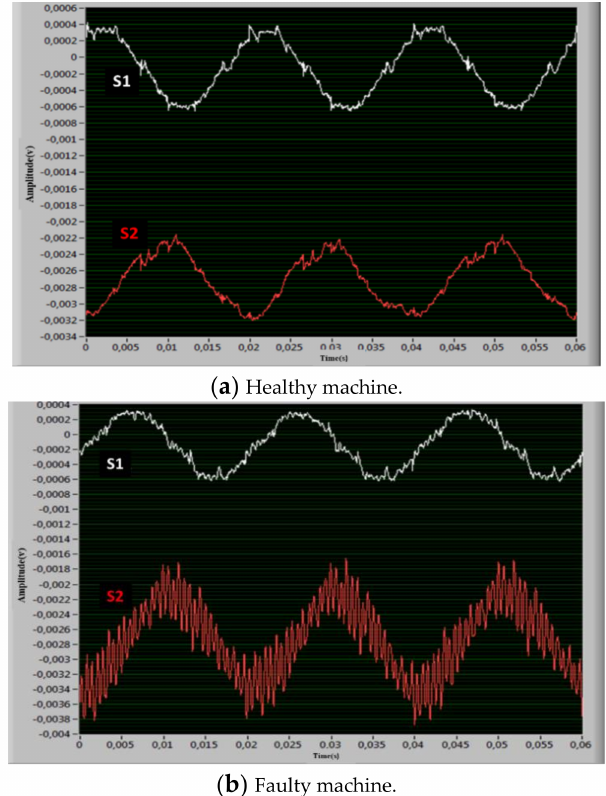
Figure 5. Signals delivered by two coil sensors S1 and S2 placed at 180 ◦ around a 10 kW synchronous machine: ( a ) electromagnetic force measured for healthy machine: ( b ) electromagnetic force measured for the faulty